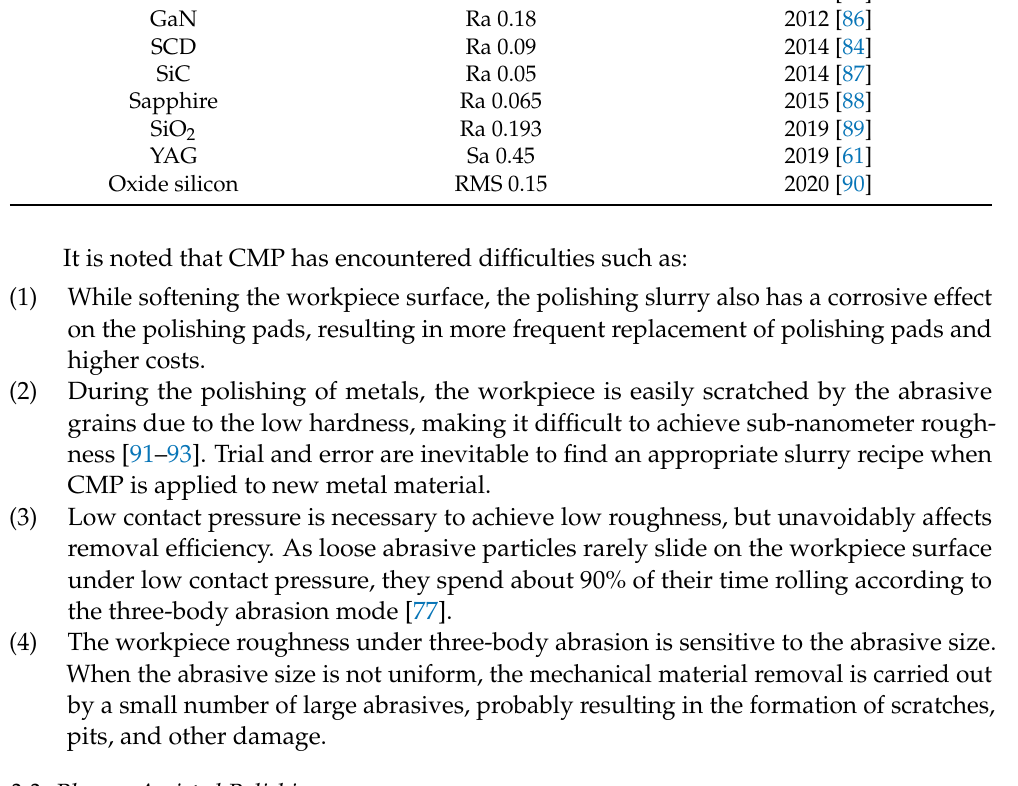
( b ) Figure 10. The removal mechanism in plasma-assisted polishing: ( a ) Cross sectional transmission electron microscopy images of H 2 O containing plasma irradiated 4H-SiC surface. Reproduced with permission from [97]; ( b ) The removal process in PAP at microscopic. The specific processing mechanism of PAP depends on the individual material. For SiC, the surface is oxidized under plasma irradiation to a soft modification layer com- posed of SiO 2 and Si-C-O [98]. The interface between the modified layers and bulk mate- rial is atomically flat. A sub-nanometer roughness is achieved on the SiC surface when the chemically modified layer is removed mechanically, as shown in Figure 11a. For GaN, the surface is fluorinated into the GaF 3 soft modified layer by CF 4 plasma irradiation. There is an atomically flat interface between the modified layer and bulk ma- terial because the dislocation sites on the surface are preferentially modified. An atomic- scale precision surface without scratches is generated when CeO 2 (softer than GaN) re- moves the modified layer [99], as shown in Figure 11b. For SCD, argon-based plasma containing water vapor is utilized in PAP to modify not only the SCD surface but also the grinding stone surface. Here, it is reported that a dehydration condensation reaction was formed between the modified surfaces of the